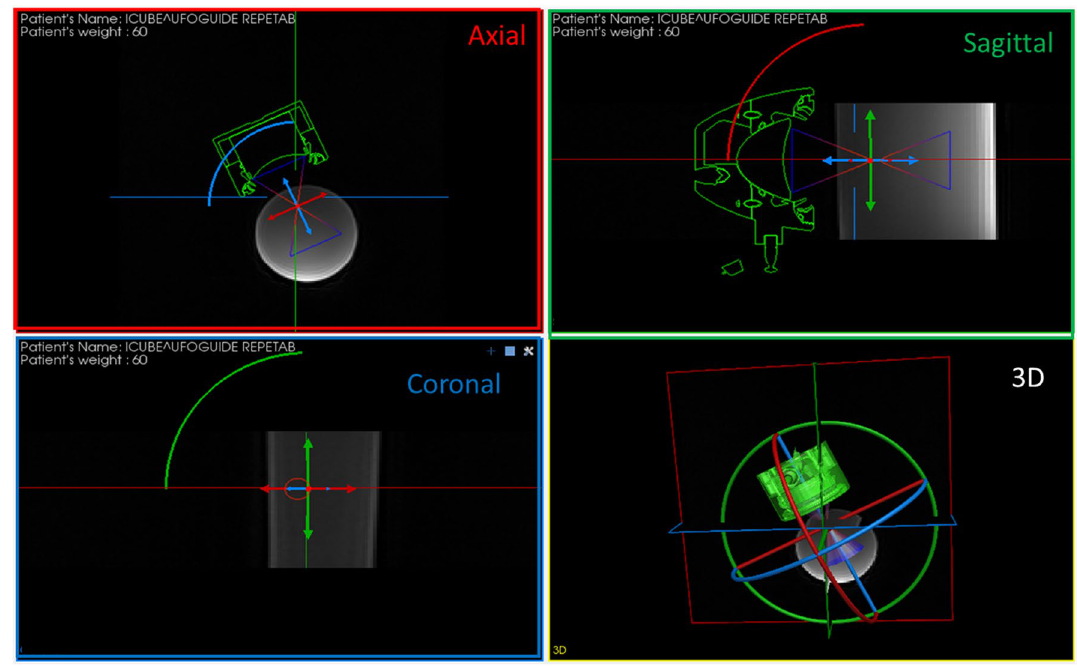
Figure 1. Preoperative planning interface illustrated on MR images of a uniform phantom. The practitioner can rotate and translate the ultrasonic transducer virtually in all imaging planes. By visualizing the anatomical structures exposed to the ultrasonic beam, the practitioner can choose the optimal transducer poses, which can be saved for the time of the intervention. Colored arcs represent the transducer pathway when performing a rotation around the focus.